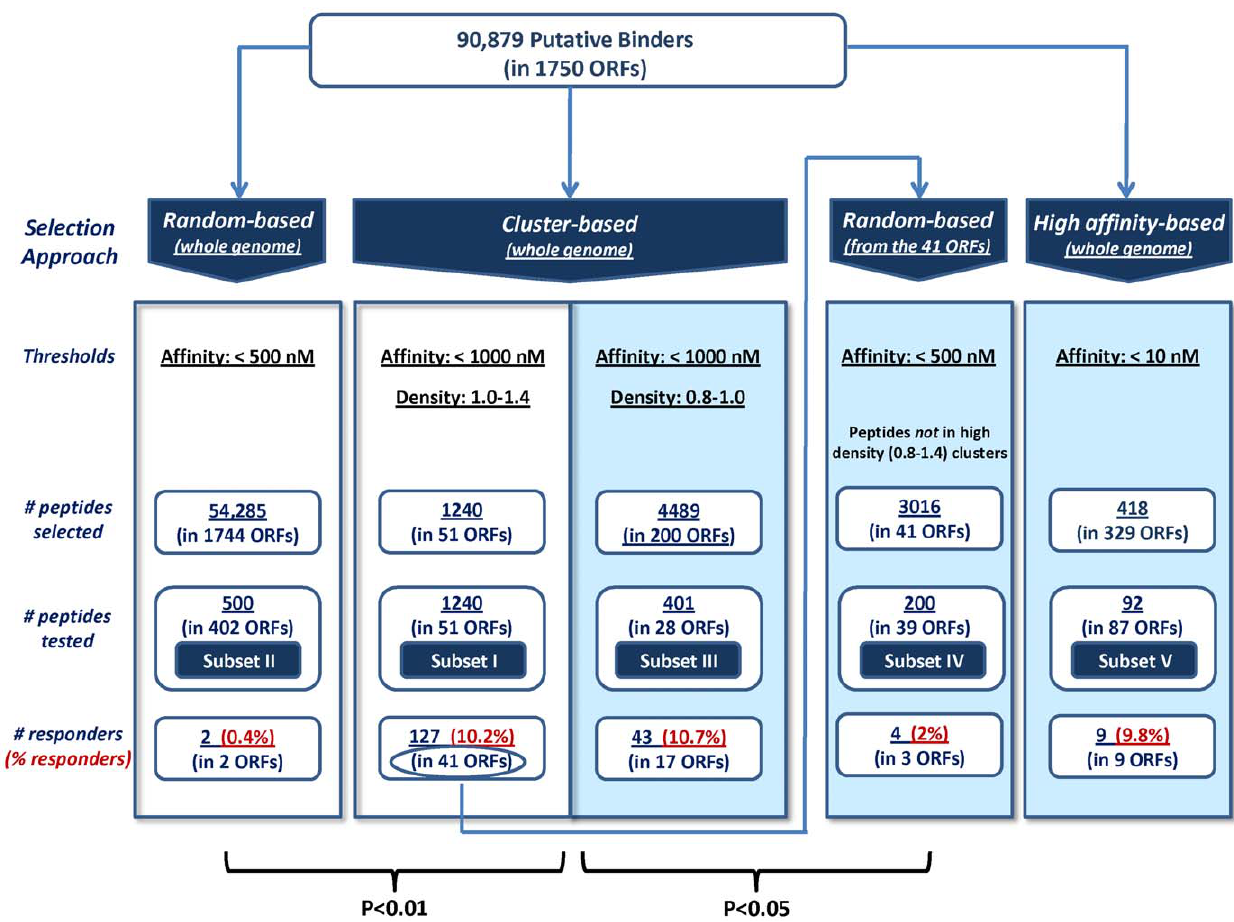
Figure 2. Array of peptides tested in the F.tularensis CTL screen in C57BL/6 LVS immunized mice. Summary of the total number of peptides selected, evaluated and responding in the various subsets (see Figure 1). Data on Subset I and II is from [14]. Peptides which were shown to stimulate lymphocytes and induce IFN c production are referred to as ‘‘responders’’. P-values are provided for evaluation of significance of difference between number of responders in the cluster-based Subsets I and III versus Subset II, and versus Subset